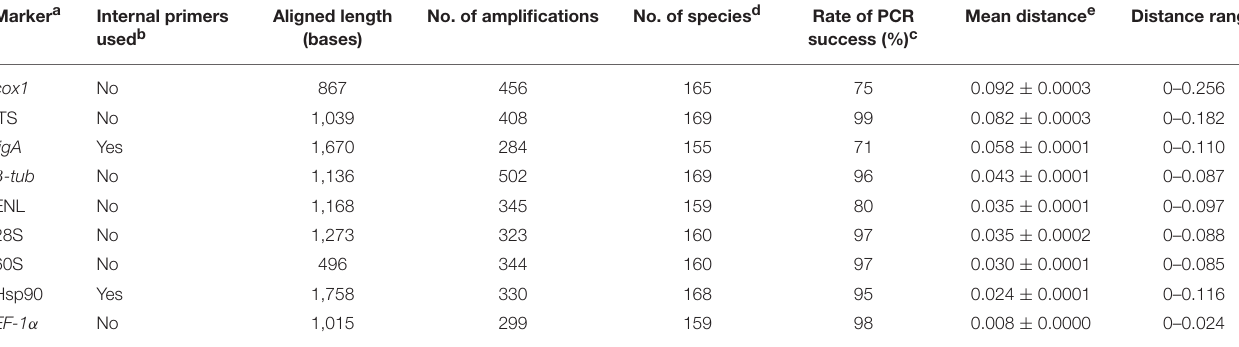
TABLE 2 | PCR consistency and overall species distance across the genus Phytophthora by genetic marker. Marker a Internal primers Aligned length used b